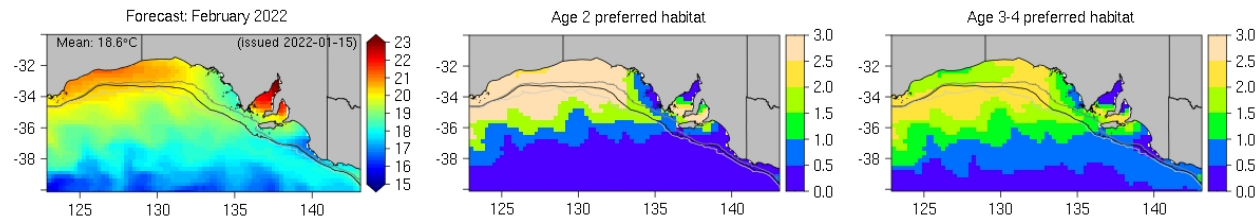
Figure 2. ( Left ) Sea surface temperature (SST) forecast (in °C) for February 2022 as predicted by the Bureau of Meteorology’s seasonal forecasting system ACCESS-S on 15 January 2022. ( Middle ) Areas predicted to contain preferred habitat for age 2 southern bluefin tuna in February 2022 based on the SST forecast on the left; colour corresponds to level of preference, where a value >1 indicates preferred habitat (up to a maximum of 3). ( Right ) Same as the middle panel except for fish ages 3–4.